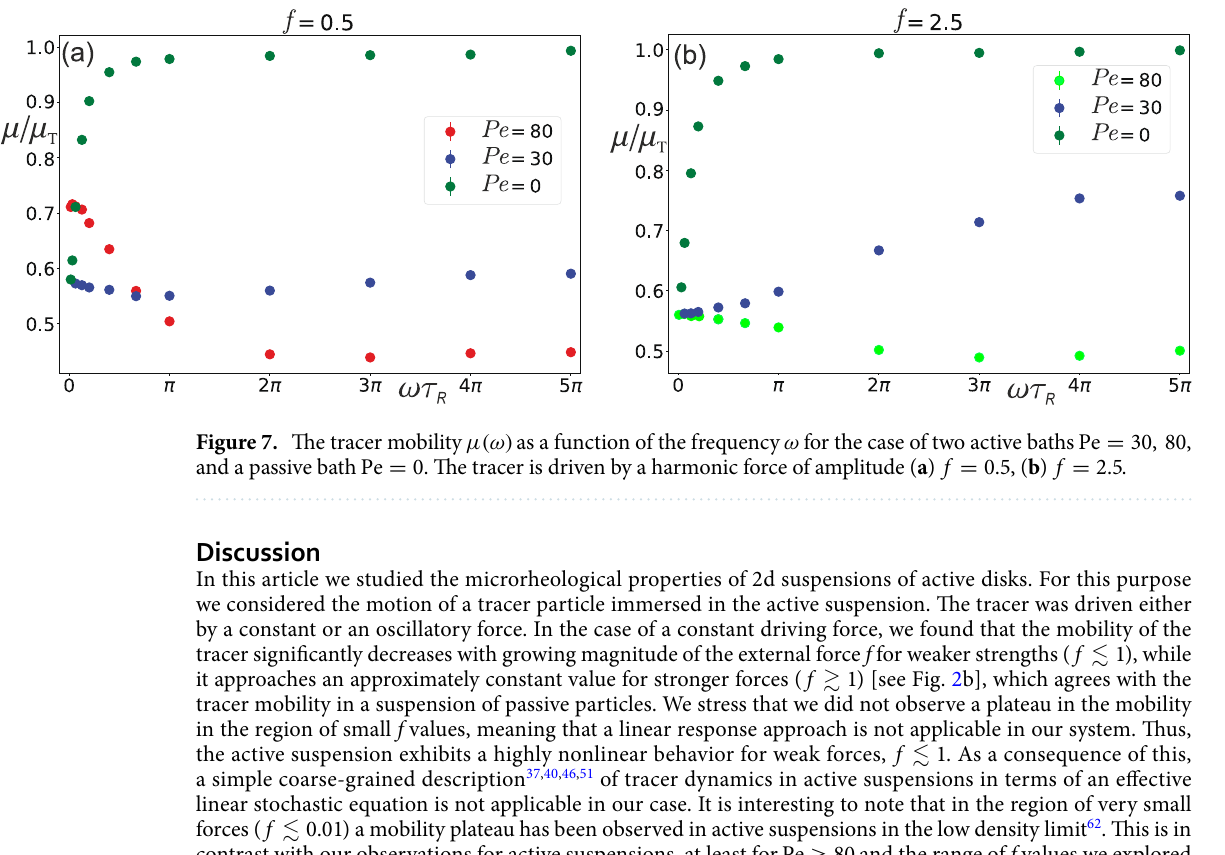
Figure 7. The tracer mobility µ(ω) as a function of the frequency ω for the case of two active baths Pe